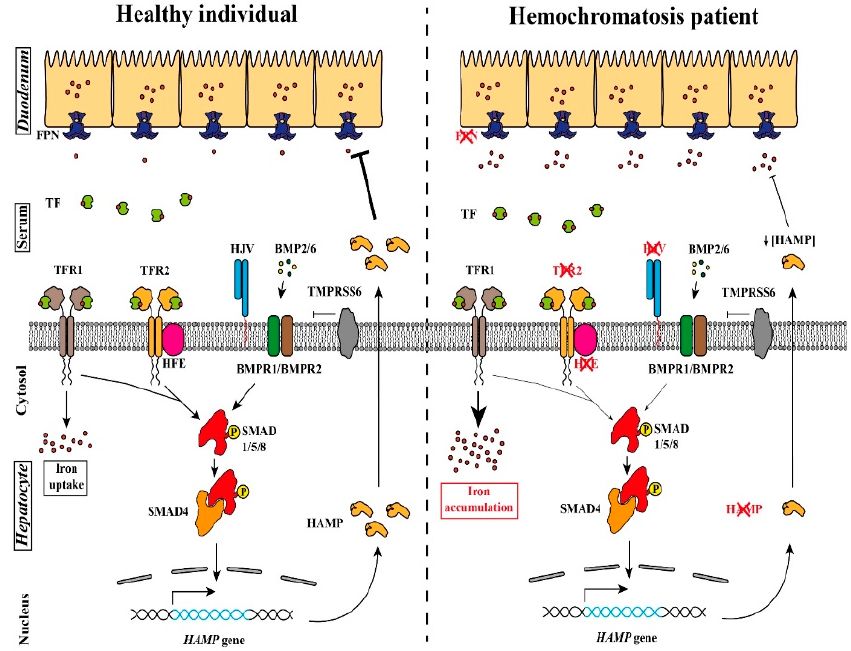
Figure 1. Model for the hepcidin expression and its alterations in hereditary hemochromatosis (HH). Left , the coordinated signaling of the TFR1, TFR2, HFE, HJV and BMP receptors activated the SMAD complex that promotes HAMP expression. The hepcidin produced is then released to the blood stream and will stimulate the FPN degradation in the duodenum epithelial cells, limiting iron absorption. Right , in an individual affected by HH, mutations in any of the proteins marked with a red cross result in a reduction in the serum hepcidin levels. This leads to an uncontrolled iron absorption by the duodenum that will result in an iron accumulation in the